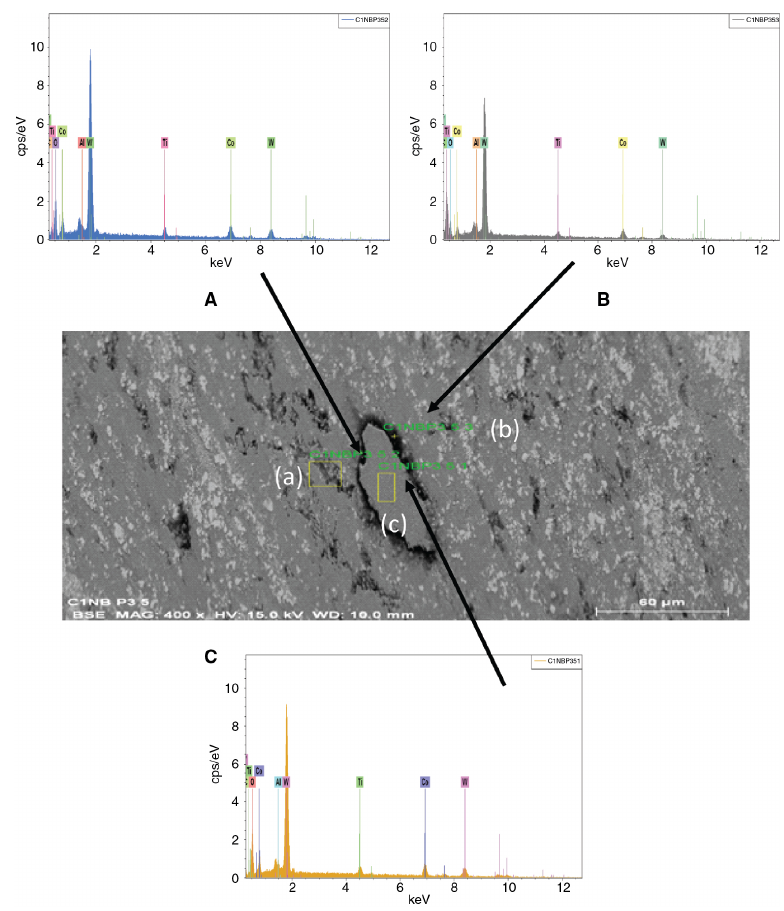
Figure 10: SEM micrographs of the wear track of grade (NB) WC-Co-5% TiC cermet when sliding against Al spectrums using temperature P1(T = 450°C) after (5000 m) of